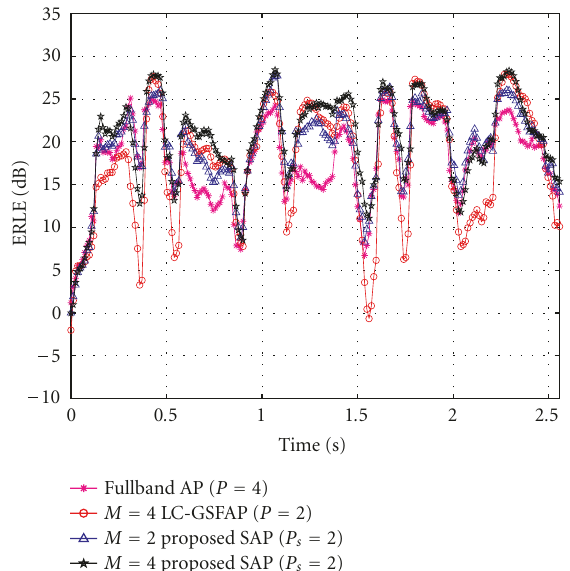
Figure 11: Comparison of ERLE for fullband AP, M = 4, OS = 2, and D = 2 LC-GSFAP, M = 2 SAP, and M = 4 SAP with 8kHz sampled speech as excitation ( N = 512, P = P s = 2, μ = 1, SNR = 30